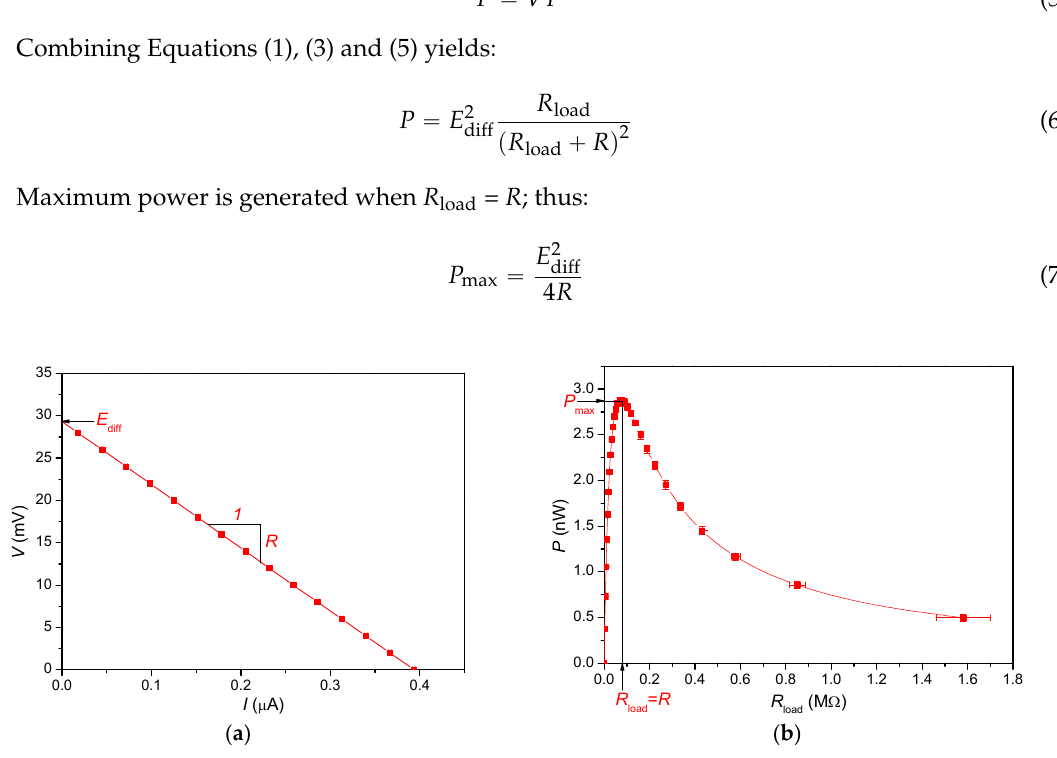
Figure 6. ( a ) V ‐ I curve and ( b ) power generation vs. R load for the silica membrane; c L = 0.1 mM and c H = 1 Mm.